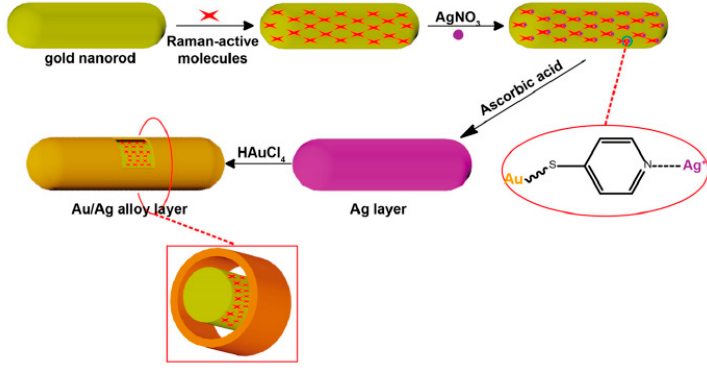
Figure 11. Schematic process for Au-AgAu core-shell structures synthesis. Reproduced from [80] with permission from the American Chemical Society.